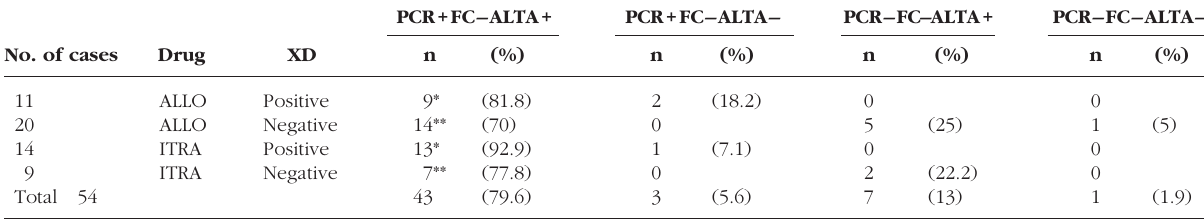
Table I. – PCR and FC-ALTA in chronic chagasic patients with positive or negative xenodiagnosis, ten years after treatment with allopurinol or itraconazole.